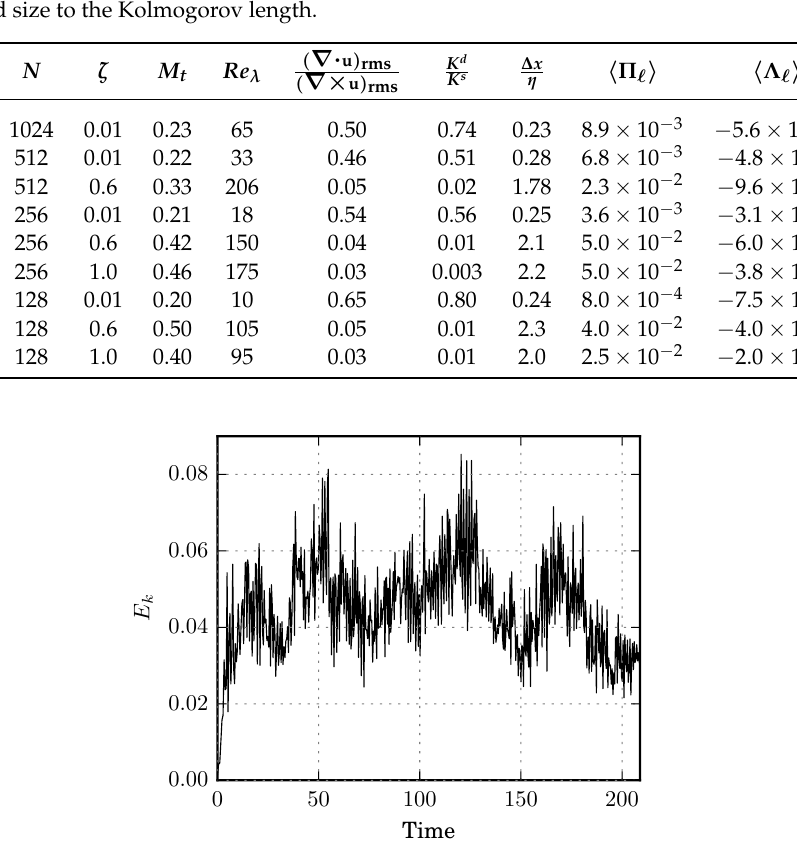
Table 1. Comparison of compressibility metrics and cascade terms at different grid resolution.